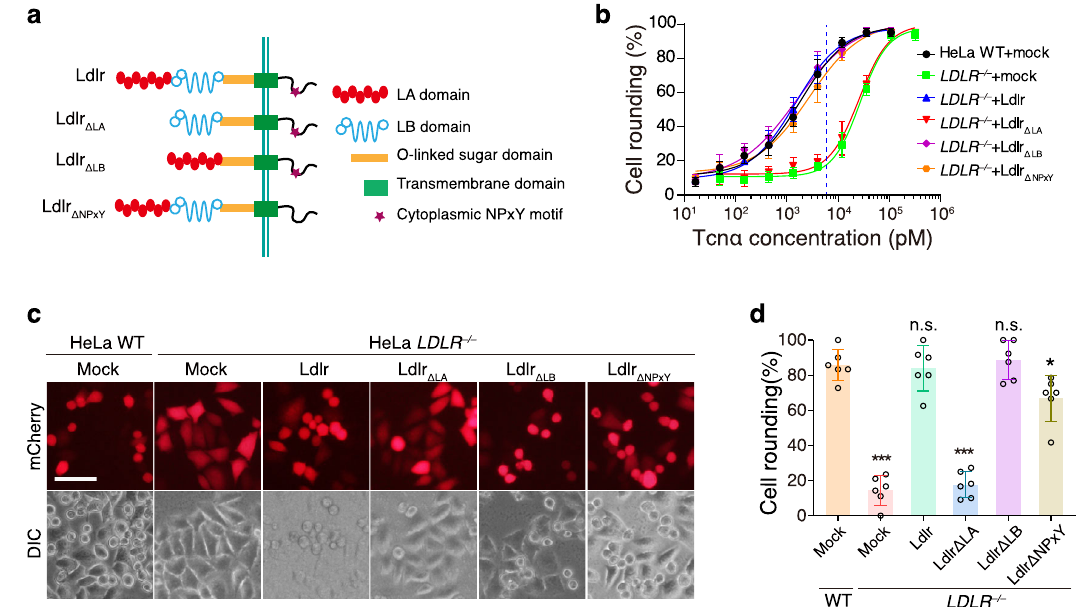
Fig. 1 The LA domain of LDLR is responsible for the uptake of Tcn α . a Schematic drawing of Ldlr, Ldlr Δ LA , Ldlr Δ LB , and Ldlr Δ NPxY . b The HeLa WT or LDLR ‒ / ‒ cells were transfected with mock, Ldlr, Ldlr α for 3 h. The percentages of round-shaped Δ LA , Ldlr Δ LB , and Ldlr Δ NPxY , followed by incubating with Tcn cells are plotted on the chart. The blue dash line indicates 6 nM. Error bars ( n = 6) indicate mean ± SD. c The indicated HeLa cells were incubated with Tcn α (6 nM, 3 h) and the images were captured. Red fl uorescence (mCherry) marked transfected cells. The scale bar represents 50 μ m. d The round- shaped cells among all mCherry-positive cells shown in c were quanti fi ed and plotted in a bar chart. Error bars ( n = 6) indicate mean ± SD, * P < 0.05, *** P < 0.001, n.s. = not signi fi cant, two-sided Student ’ s t